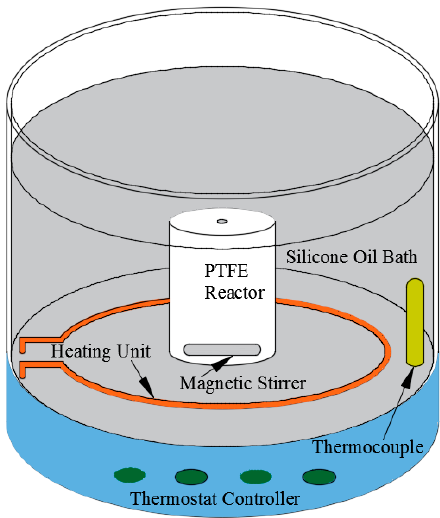
Figure 2. Schematic of the leaching experimental apparatus.